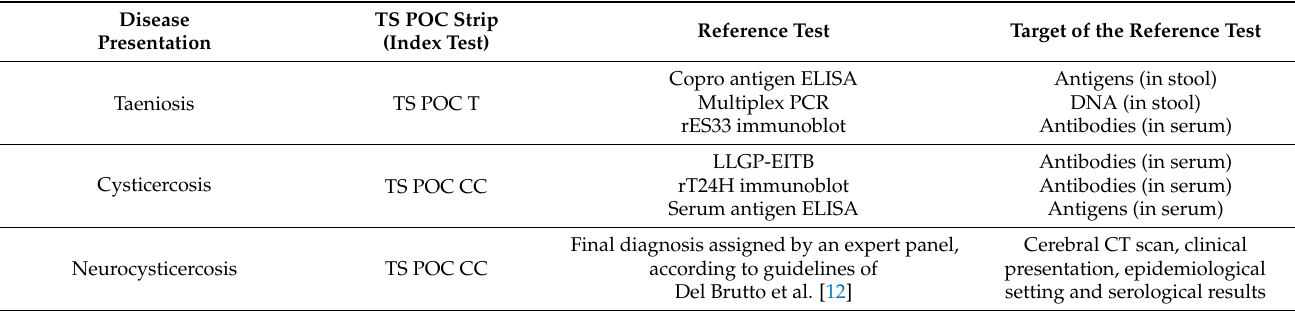
Table 1. Reference tests to assess the sensitivity and specificity of the TS POC test for different disease presentations of T. solium .